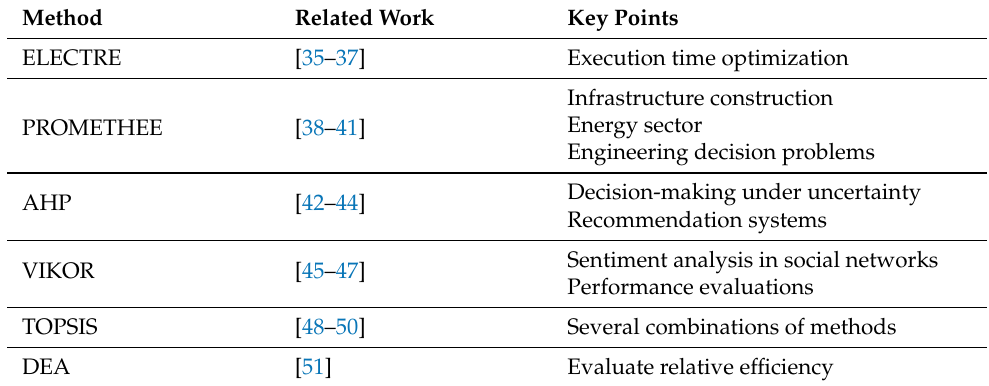
Table 2. MCDM method